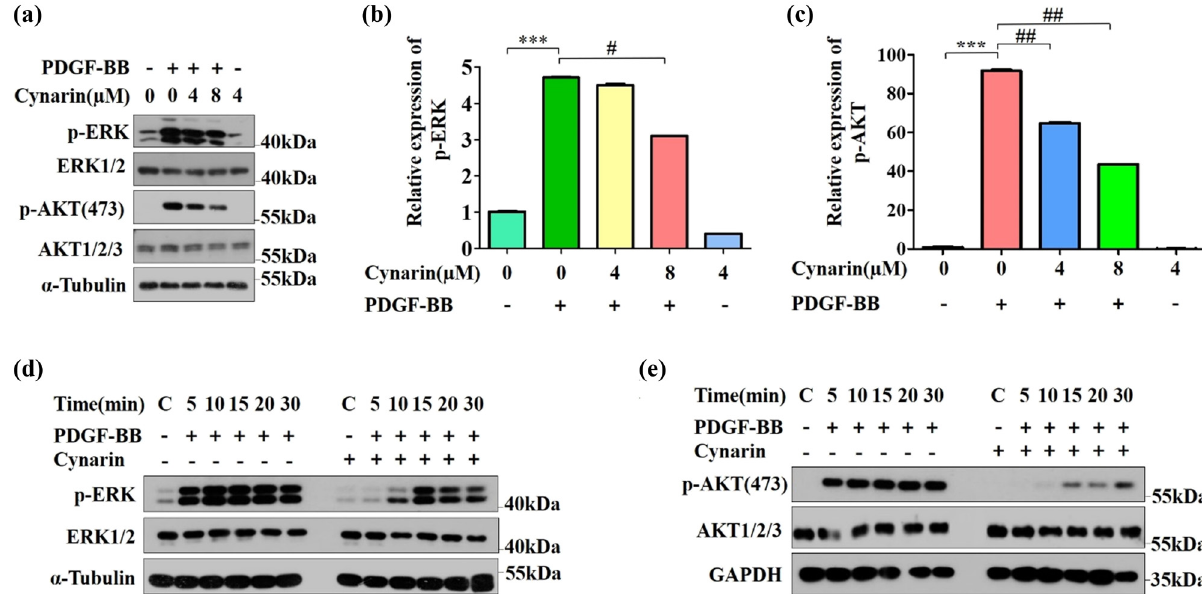
Figure 4: Cynarin inhibits PDGF - BB - induced expression of p - AKT and p - ERK. ( a – c ) Cynarin dose dependently inhibits the expression of p - ERK and p - AKT induced by PDGF - BB. ( d ) Cynarin inhibits the expression of p - ERK induced by PDGF - BB ( 10 ng/mL ) as indicated. ( e ) Cynarin inhibits the expression of p - AKT induced by PDGF - BB ( 10 ng/mL ) as indicated. *** p < 0.001 vs vehicle group, # p < 0.05 vs PDGF - BB group, ## p < 0.01 vs PDGF - BB group, n =